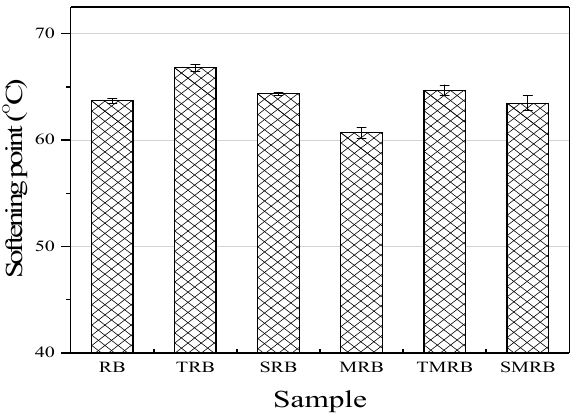
Figure 3. Softening point of rubberized bitumen.